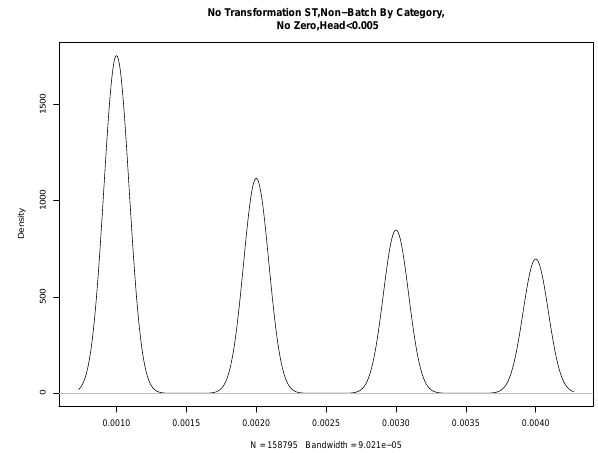
Figure 11. Batch by category discrete values, ST, head.